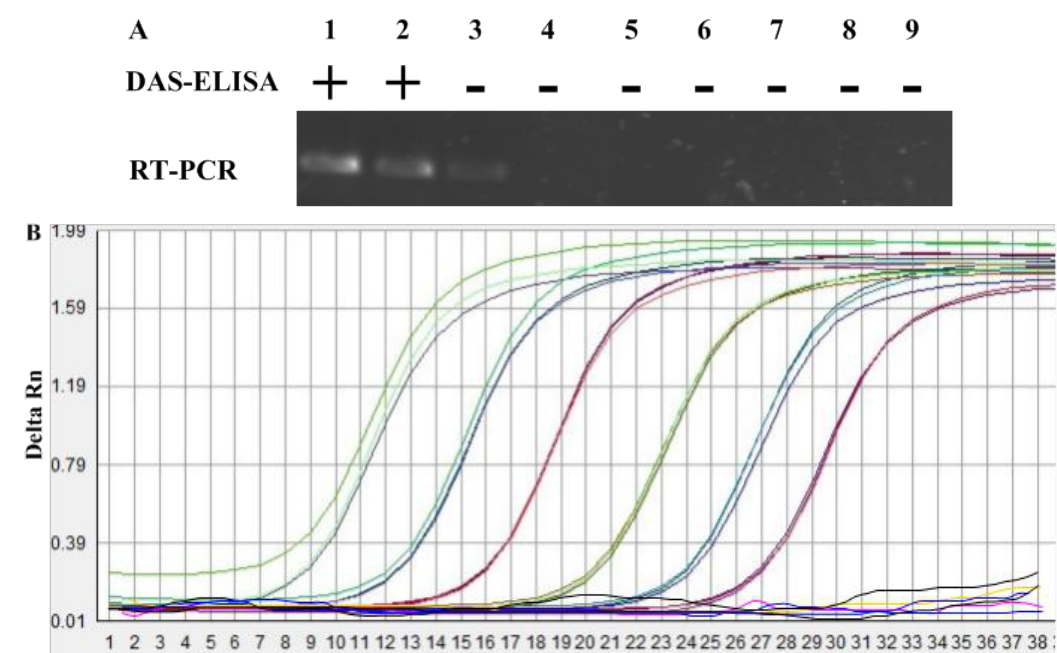
Figure 1. The detection of TMV in soil by the assays of DAS-ELISA ( A ), RT-PCR ( A ) and IC-real-time RT-PCR ( B ). Lanes 1 to 6 are the detections of TMV in one gram soil samples artificially blended with different dilutions naturally TMV-infected leaf at 1:10 1 , 1:10 2 , 1:10 3 , 1:10 4 , 1:10 5 and 1:10 6 (1 mL, w/v, g/mL), respectively, and, Lanes 7 to 9 are the detection of TMV from ToMV-contaminated soil, TMV-free soil, and healthy leaf extract, respectively. “+” represents positive result of DAS-ELISA for detecting TMV, “−” represents negative result of DAS-ELISA for detecting TMV. (B) Sensitivity of the IC-real-time RT-PCR assay as monitored by amplified curve. Shown from left to right are the curves of soil contamined with decreasing TMV-infected leaf saps at 1:10 1 , 1:10 2 , 1:10 3 , 1:10 4 , 1:10 5 and 1:10 6 (1 mL, w/v, per g soil) dilutions. The curves roughly parallel to the X axis are TMV from ToMV-contaminated soil, TMV-free soil, and healthy leaf extract,